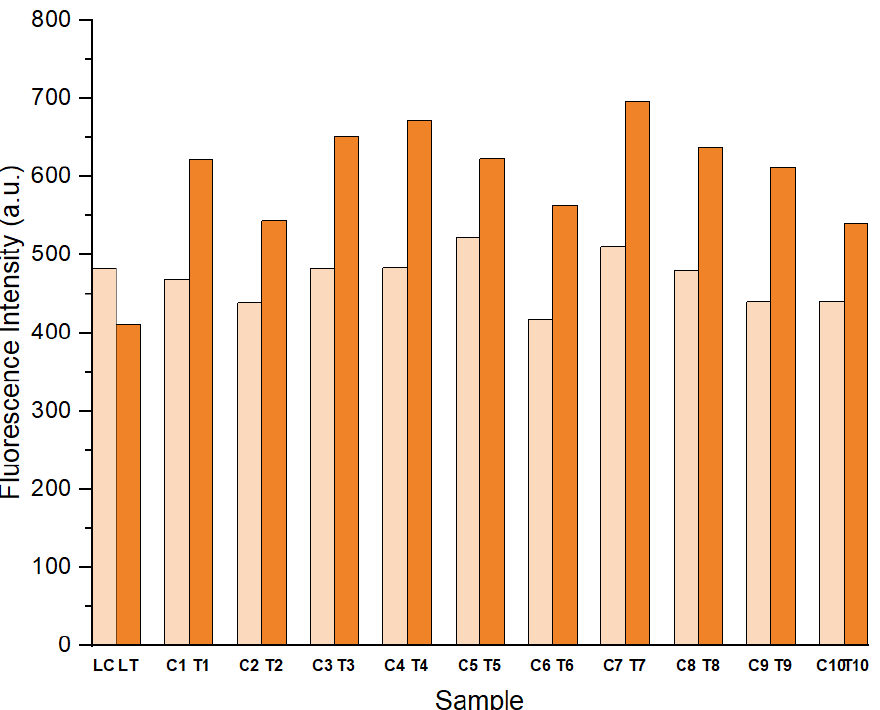
Figure 4. The maximum fluorescence intensity of each sample at emission wavelength 489 nm ( LC = latex (without torn), LT = torn latex, C = control (i.e., without any tear), T = torn on the film.